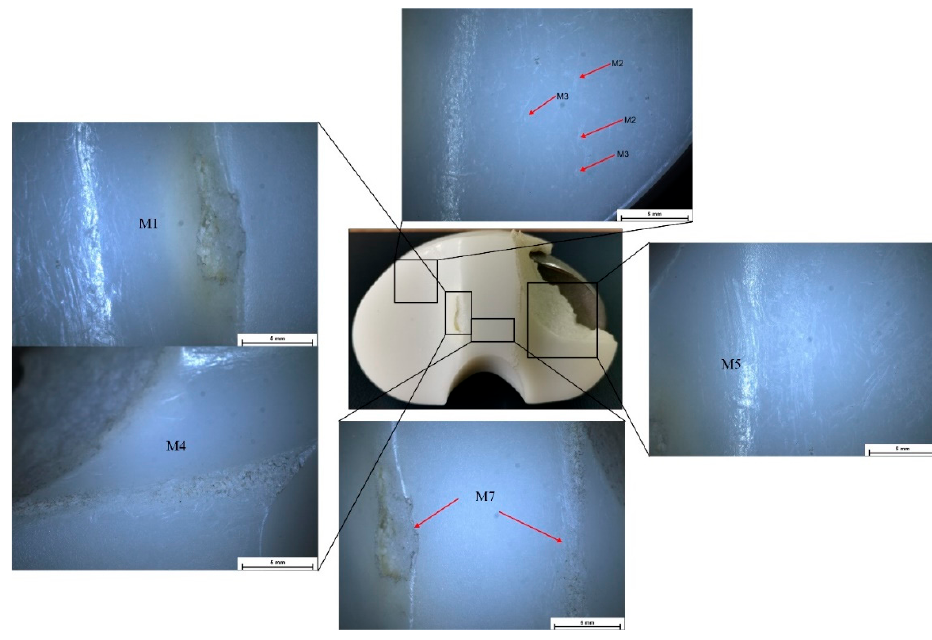
Figure 7. Stereomicroscopy images obtained in the case of IT4 sample.